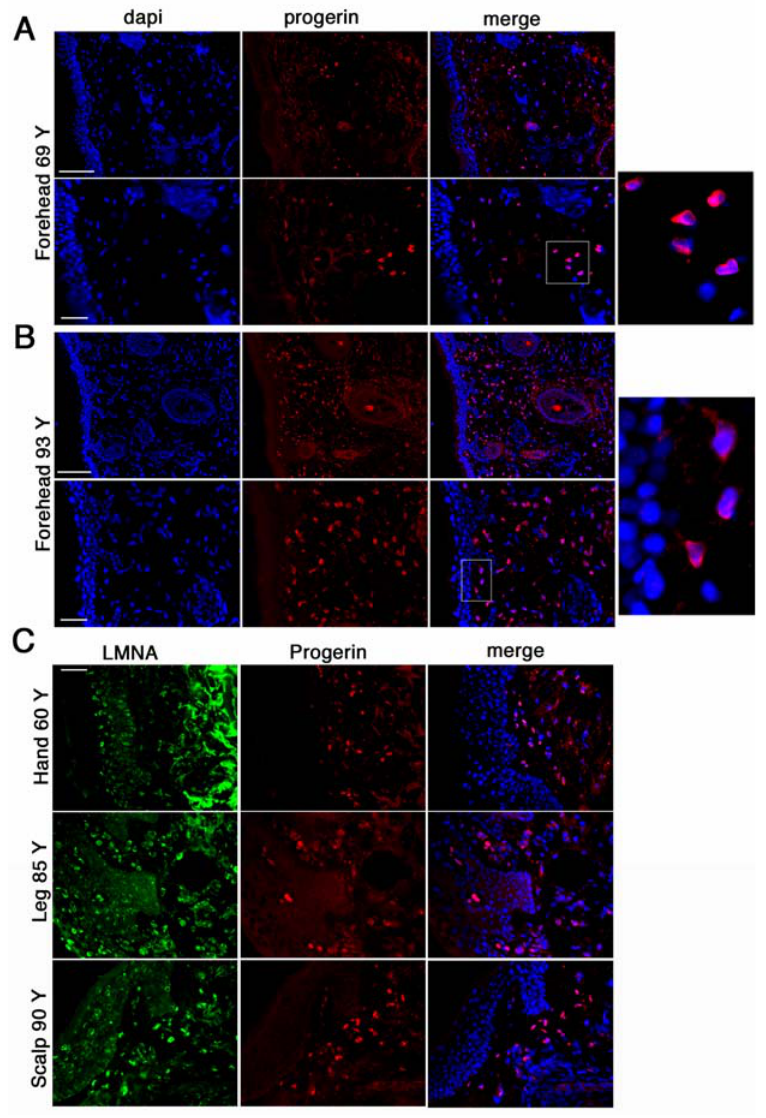
Figure 4. Progerin accumulation in human elderly skin biopsy sections . A , Forehead skin section from a 69-year-old individual probed with anti- progerin antibody and counterstained with dapi. Bars correspond to 100 and 50 m m, respectively. B , Forehead skin section from a 93-year-old donor. C , Skin sections from different body sites as indicated were probed with anti-progerin and anti- lamin A (LMNA) antibodies. Bar, 50 m m. Merged images are indicated.